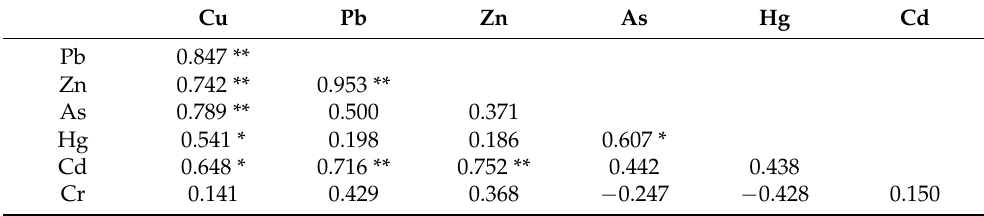
Table 5. The 2012 Pearson matrix of sediment heavy metal variables correlation.